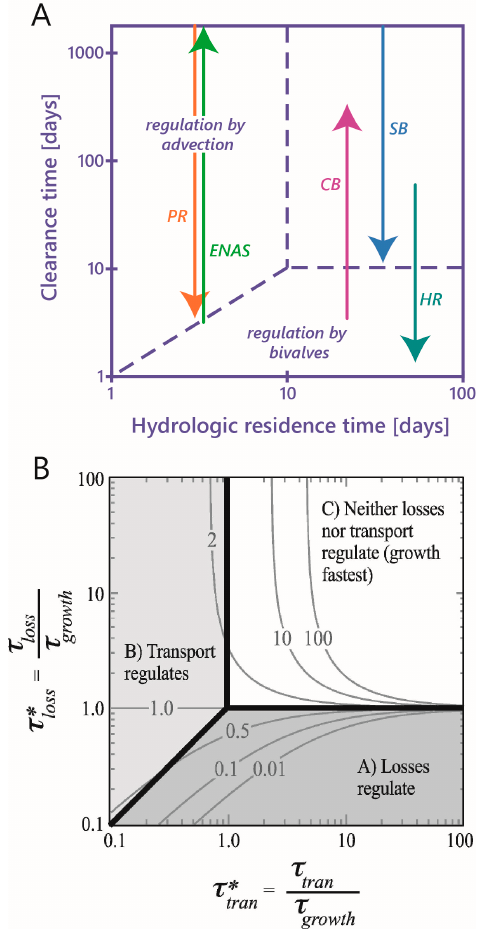
Figure 19. ( A ) The conceptual model of Strayer et al. [232], which extended that of Dame [233] and described three domains of control of phytoplankton (i.e., by advection, bivalve grazing, or phytoplankton growth). Strayer et al. [232] explained that domain boundaries may be different from those shown, depending on phytoplankton net growth rates. Arrows describe how bivalve clearance times in five estuarine, river, and stream ecosystems changed over time as a result of bivalve invasion or population decline. Ecosystems are the following: HR , the Hudson River (New York, USA) after the Dreissena polymorpha (zebra mussel) invasion; SB , Suisun Bay (California, USA) after invasion by Potamocorbula amurensis ; CB , the Chesapeake Bay (USA) after the decline of oyster populations; ENAS , a typical eastern North American stream after unionid decline; and PR , the freshwater tidal Potomac River (Maryland, USA) after the Corbicula fluminea invasion. (Redrawn from Strayer et al. [232] with the permission of D. Strayer.) ( B ) Reprise of Figure 15 with shaded areas added to describe domains of control on phytoplankton biomass [23], extending the conceptual model of Strayer et al. [232] in panel ( A ). Contours represent values of 𝐵 (cid:3042)(cid:3048)(cid:3047)∗ , the ratio of outgoing algal biomass concentration to incoming concentration. (From Lucas et al. [23].)